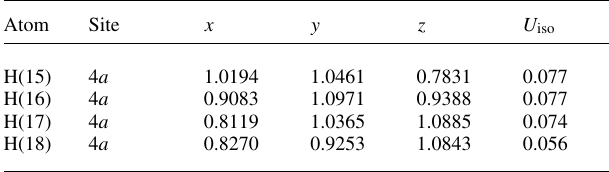
Table 3. Atomic coordinates and displacement parameters (in Å 2 )